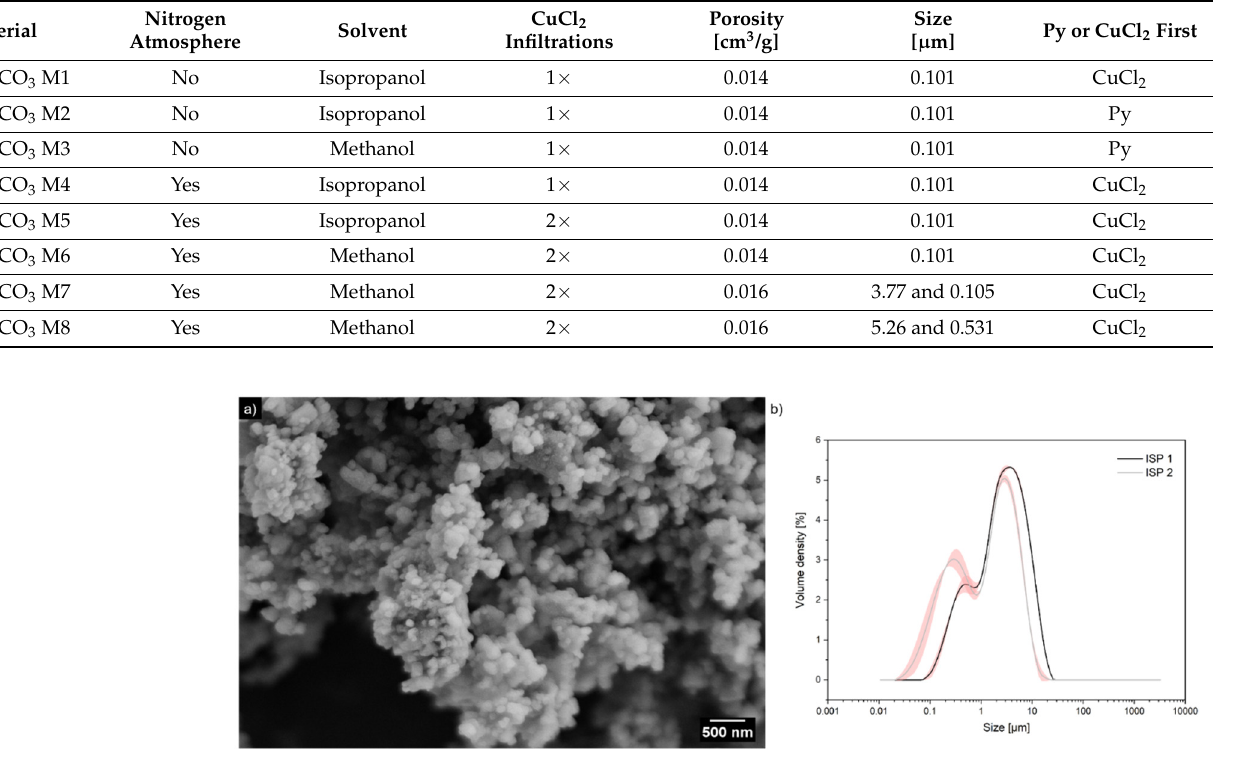
Figure 1. ( a ) SEM image of immature seashell particles (ISP) and ( b ) size distribution of seashell particles: the particle size distribution is obtained using laser diffraction in isopropanol. The graph shows the size distribution of immature seashell particle batches, including the first batch, ISP 1, with particle sizes of 5.26 µm (area = 42.77% µm) and 531 nm (area = 0.471% µm), and 3.77 µm (area = 0.1% µm) and 105 nm (area = 0.004% µm) for the second batch, ISP 2 (gray line). The red area in both curves depicts the error area.